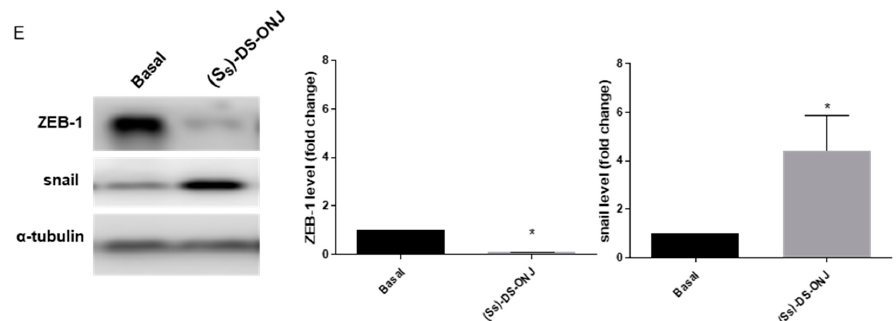
Figure 8. The EMT status in AK explants from pre-diabetic BB rats is not reverted by ( S S )-DS-ONJ. ( A ) Protein extracts were analyzed by Western blot with antibodies against E-cadherin, α -SMA and α -tubulin as a loading control (n = 6 AK explants per condition). ( B ) Immunohistochemical analyses of E-cadherin (upper panel) and α -SMA (bottom panel). Original magnification: 20×. Scale bar = 0.5 mm; n = 4 AK explants per condition. Three individual slides from six different animals were ana- lyzed. ( C ) Tgfb , Cadherin-1 and Acta-2 mRNA levels were determined by qRT-PCR and Actinb was used as housekeeping control. ( D ) Il18 mRNA levels were determined by qRT-PCR and Actinb was used as housekeeping control (n = 6 AK explants per condition). Three individual slides from six different animals were analyzed. ( E ) Protein extracts were analyzed by Western blot with antibodies against ZEB-1, snail and α -tubulin as a loading control. (n = 6 AK explants per condition). The fold change relative to the basal condition is shown; * p ≤ 0.05 vs. Basal condition (Mann–Whitney test).